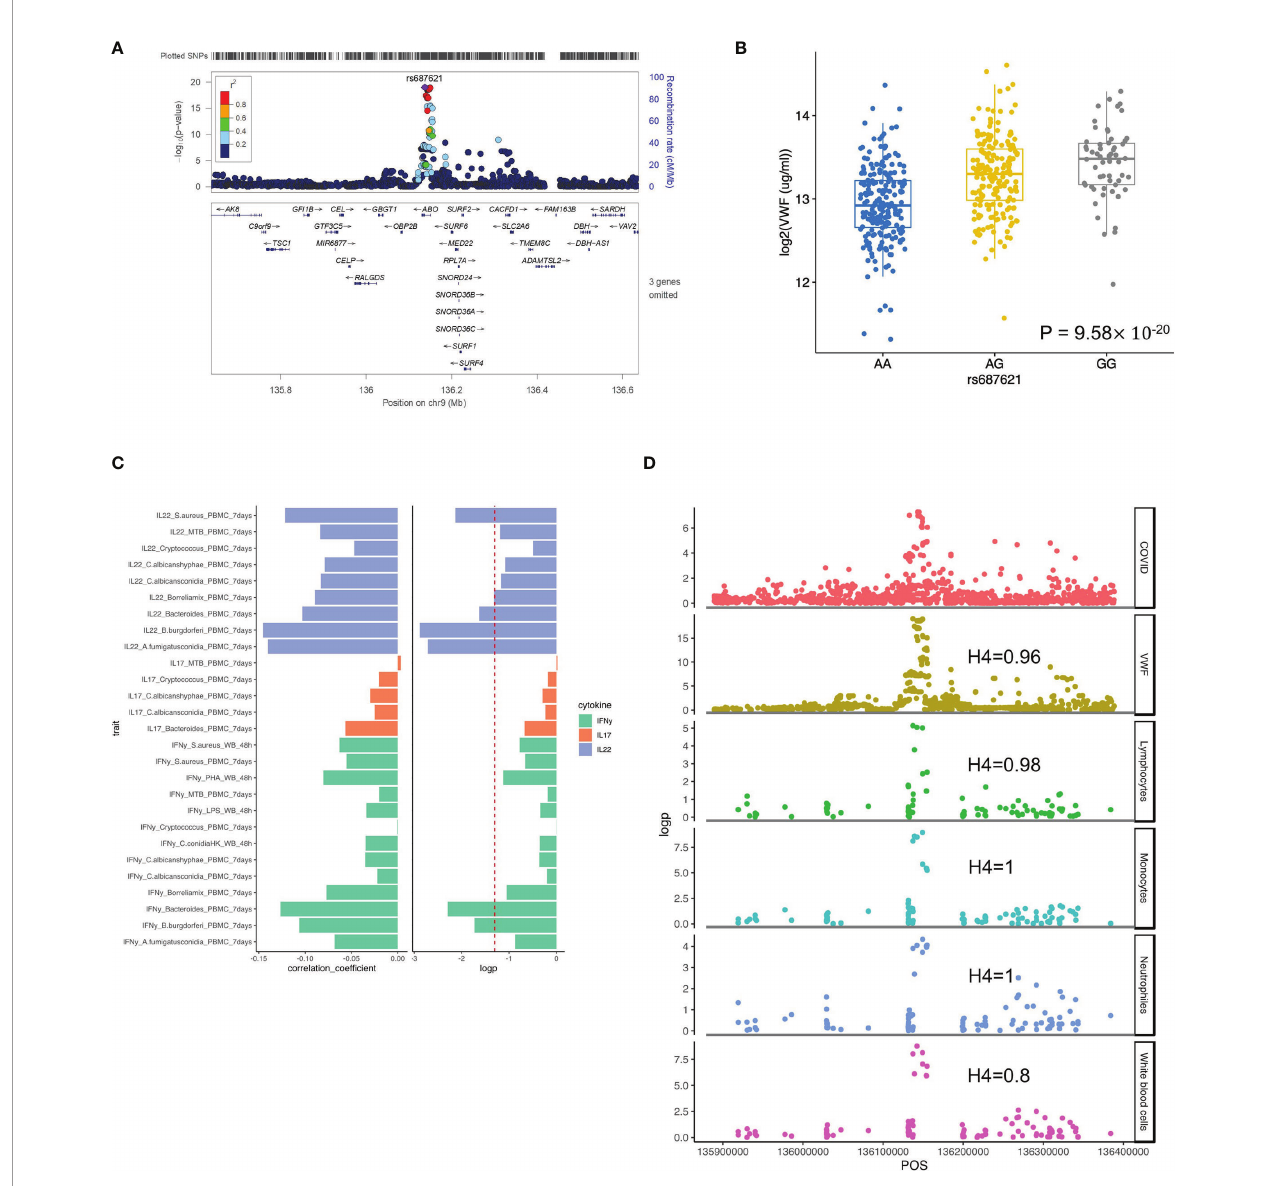
FIGURE 3 | Functional annotation of ABO loci. (A) locus zoom plot showing the signi fi cant association between ABO loci and VWF level. (B) a boxplot showing COVID-19 risk allele(rs687621-G) associated with increasing VWF level (ug/ml) (p-value = 9.58×10 -20 ). (C) a barplot showing consistent negative correlations between VWF levels and T cell-derived cytokines (D) scatter plots showing colocalization between ABO loci with VWF, lymphocytes, monocytes, neutrophils and white blood cell